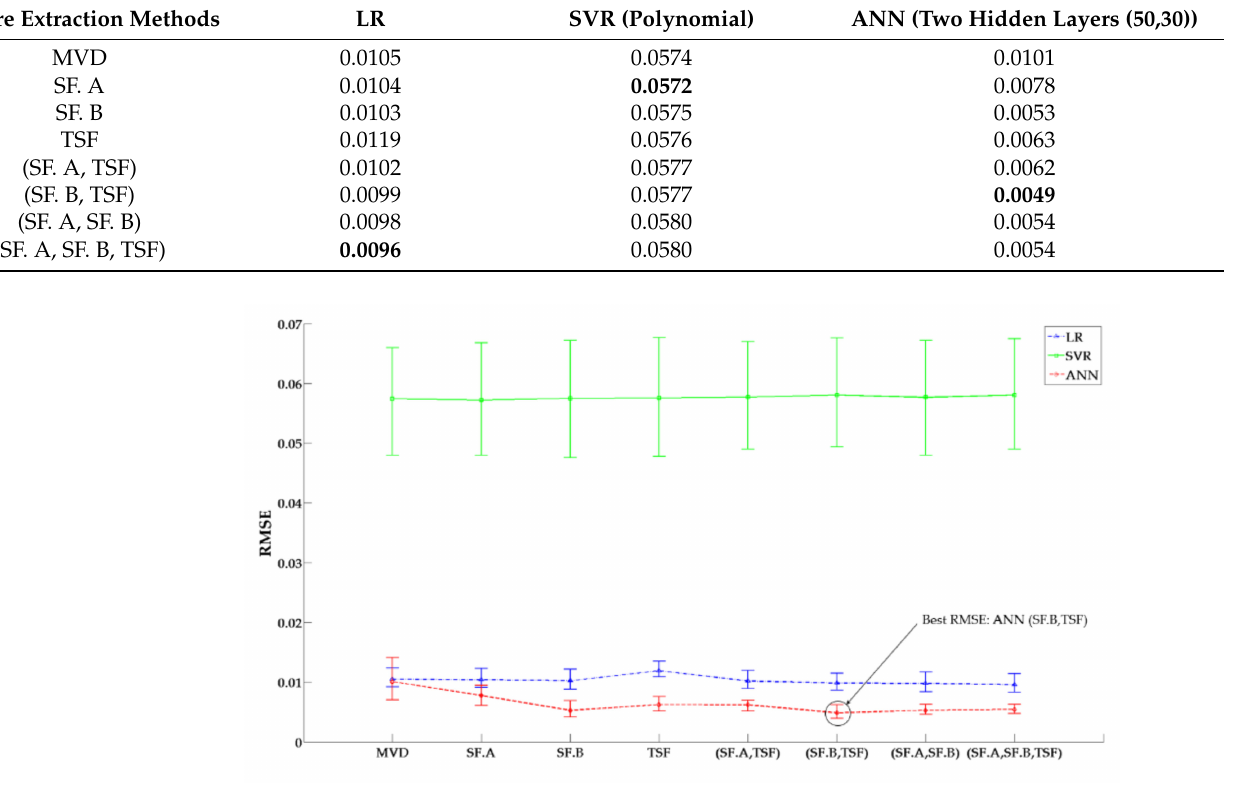
Table 6. Comparison of feature extraction methods based on various machine learning methods.